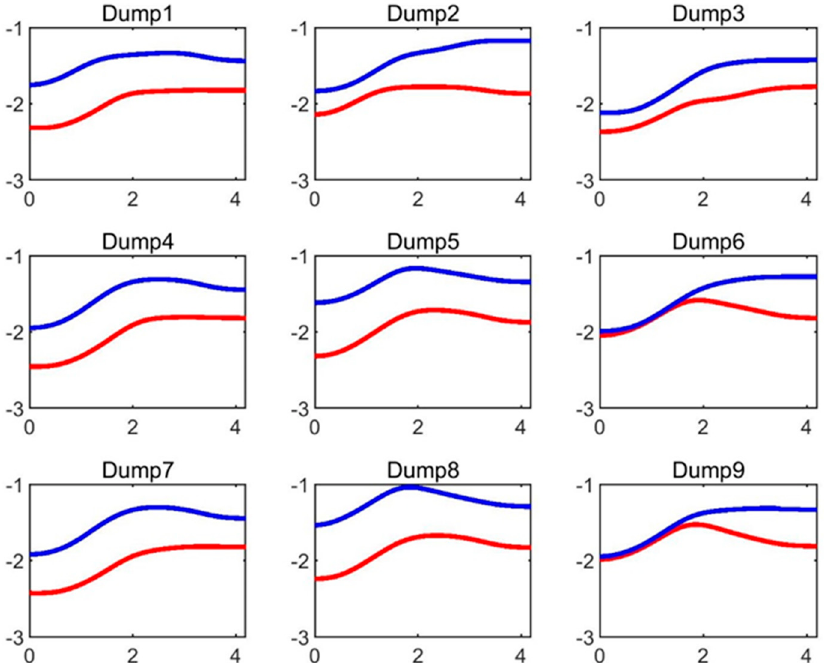
Figure 11. Average radial stock profile before (red) and after (blue) each dump reconstructed from top scanner data.